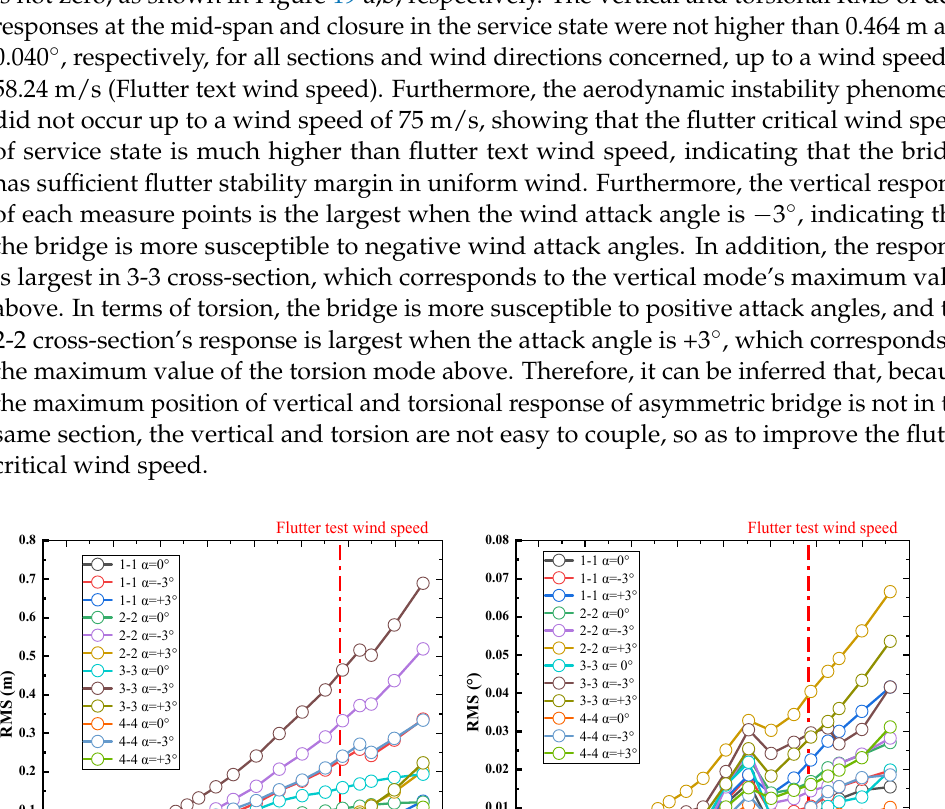
( b ) Figure 20. The root mean square (RMS) value of the displacement of each measure point of the service state in turbulent wind. ( a ) Vertical; ( b ) torsional. 6. Conclusions The vibration test of the sectional model at two wind fairing angles—sharp and blunt—was used to evaluate the VIV performance of the box girder section with different wind fairing angles. Meanwhile, the VIV, flutter, and buffeting of the bridge, which is a